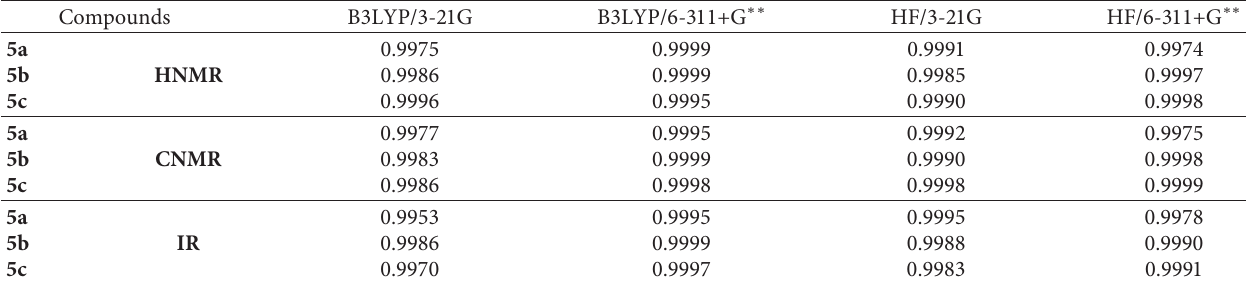
Table 11: Correlation of calculated and experimental 1 H NMR, 13 C NMR, and IR of the compounds.